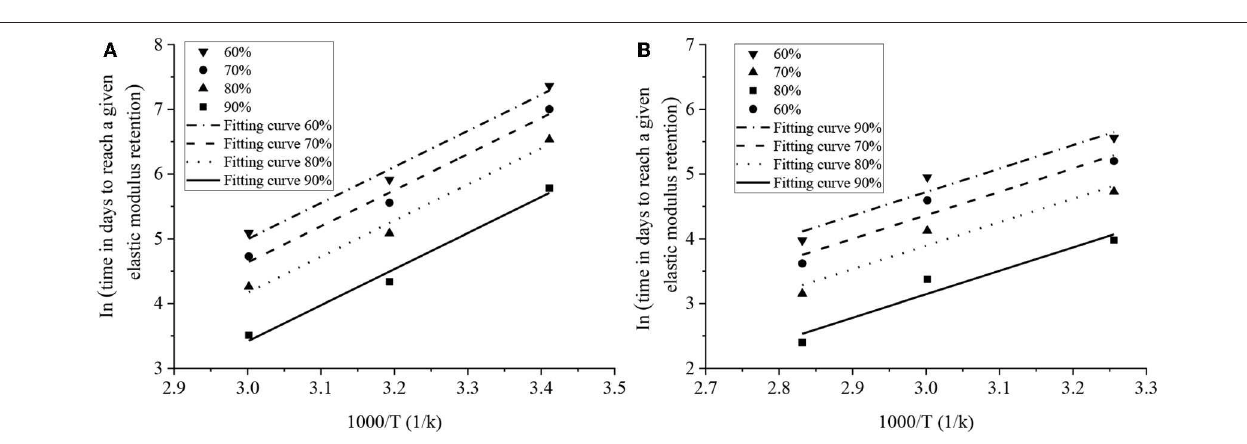
FIGURE 7 | Arrhenius plots of elastic modulus degradation: (A) Liu et al. (2016) and (B) Zhang